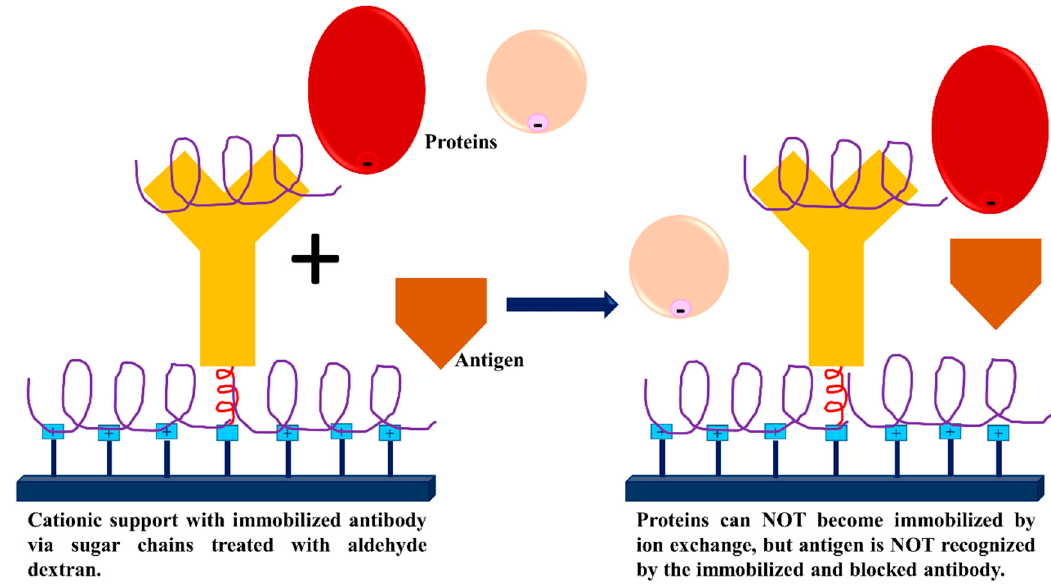
Figure 12. Antibodies immobilized on aminated supports coated with dexOx the unspecific adsorption of proteins in the support is prevented, but the function of the antibody is also eliminated.